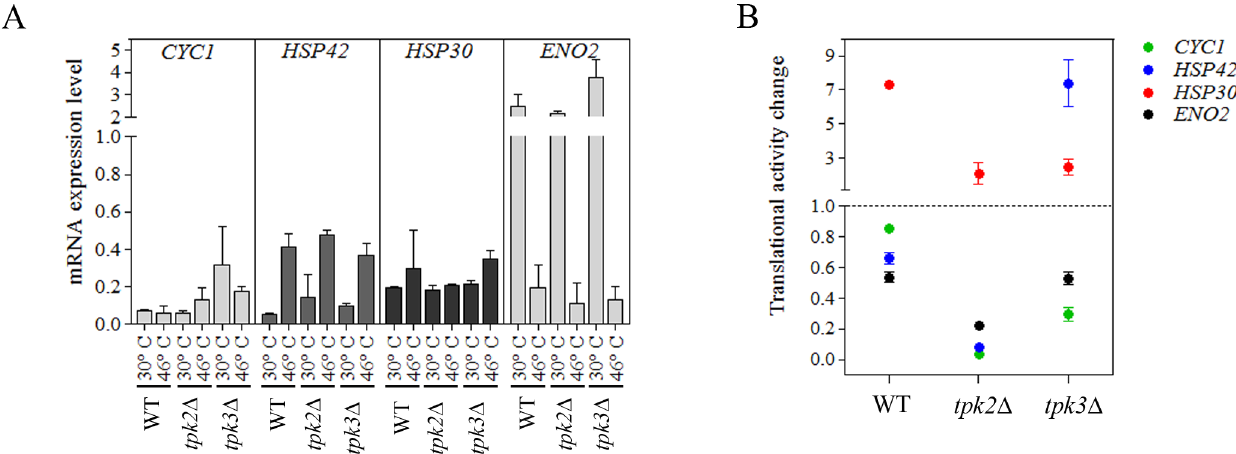
Fig 6. Tpk2 and Tpk3 affect the translational response to severeheat stress. (A) mRNA expressionlevel was determinedby q-RT-PCR on samples before and after severe heat stress. The value representsmean +/- SEM, n = 2. ACT1 mRNA was used as a control. (B) The RNA collectedfrom sucrose gradientfractions was pooledinto monosome (M) and polysome(P) fractions. The mRNA distributionwas analyzedby qRT-PCR and quantifiedrelative to a luciferase mRNA control. Translational activity changewas calculatedas describedin Materials and Methods. The values represent mean from two independentsamples. The value represents mean +/- SEM, n = 2.